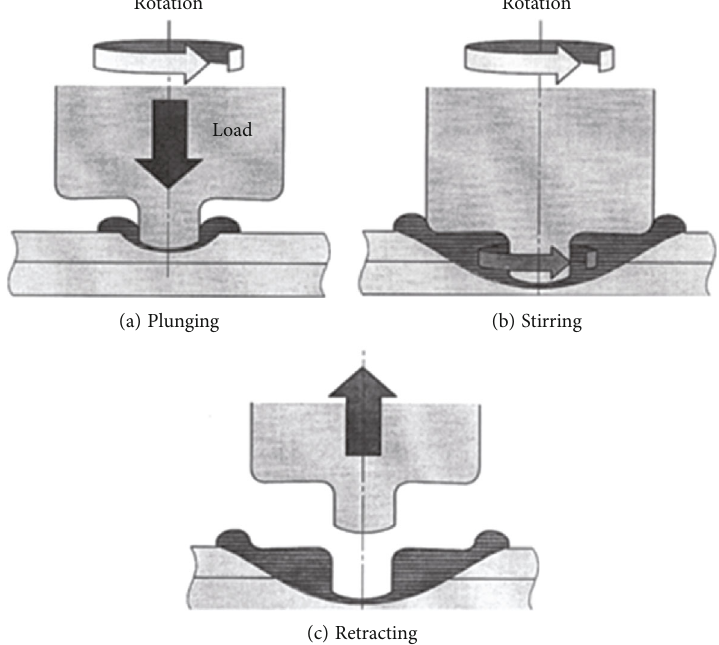
Figure 1: Graphic representation of friction stir spot welding process.